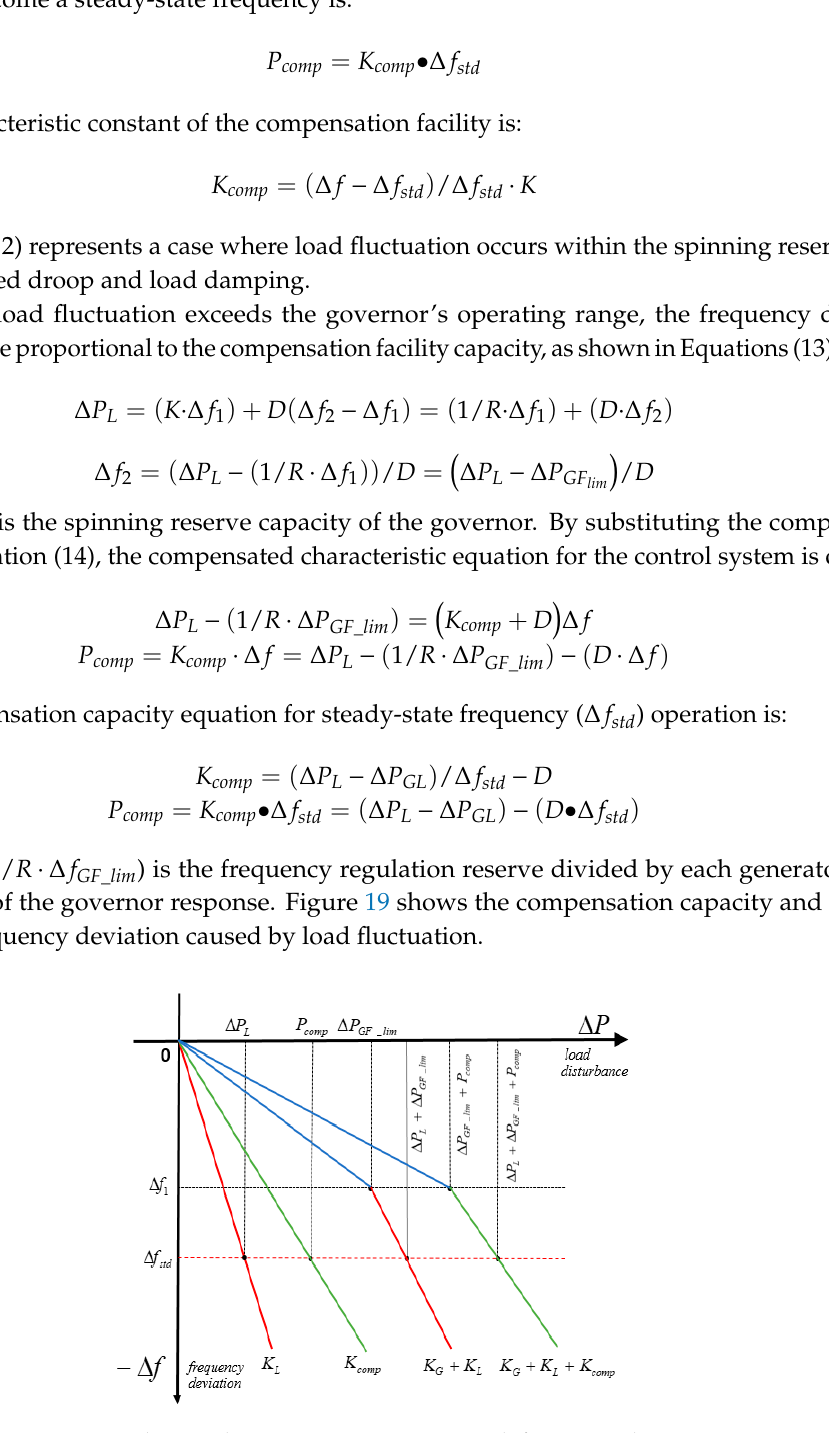
Figure 19. Slope and compensation capacity with frequency deviation.